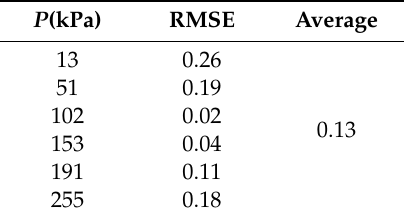
Table 3. Root mean square errors (RMSEs) of the soil samples.